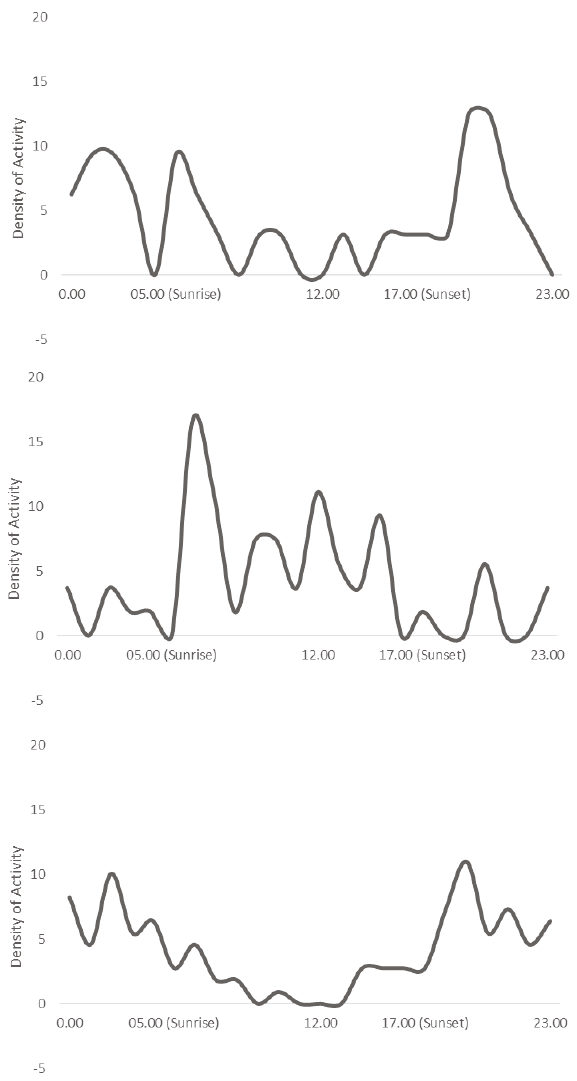
Figure 3. Kernel density estimates of activity patterns of species using alpha of 0.1 smoothing parameter: a - Flat-headed Cat; b - Marbled Cat; c - Sunda Leopard